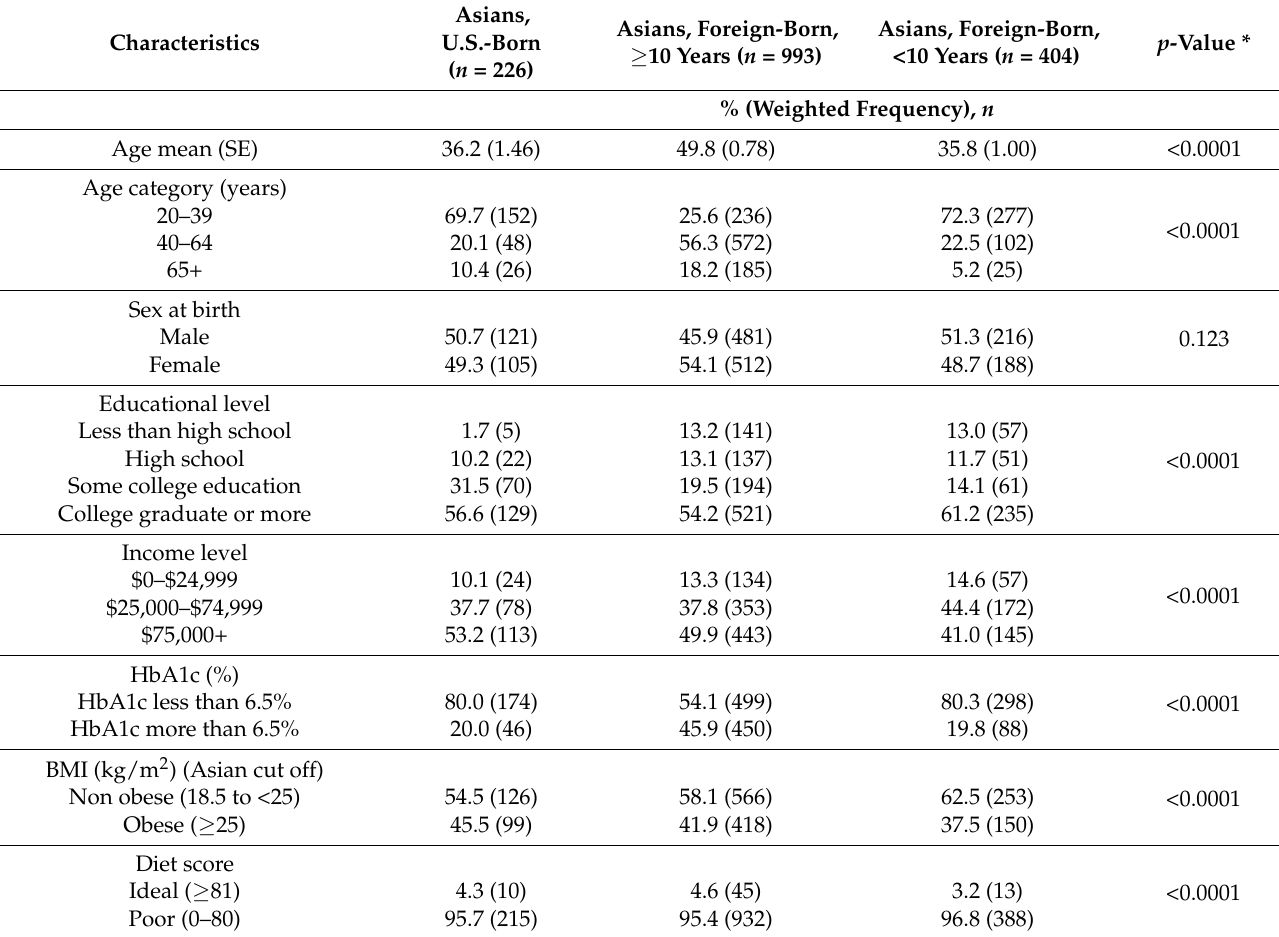
Table 1. Weighted demographic characteristics of Asian Americans by nativity and length of stay, NHANES 2011–2016 (n =